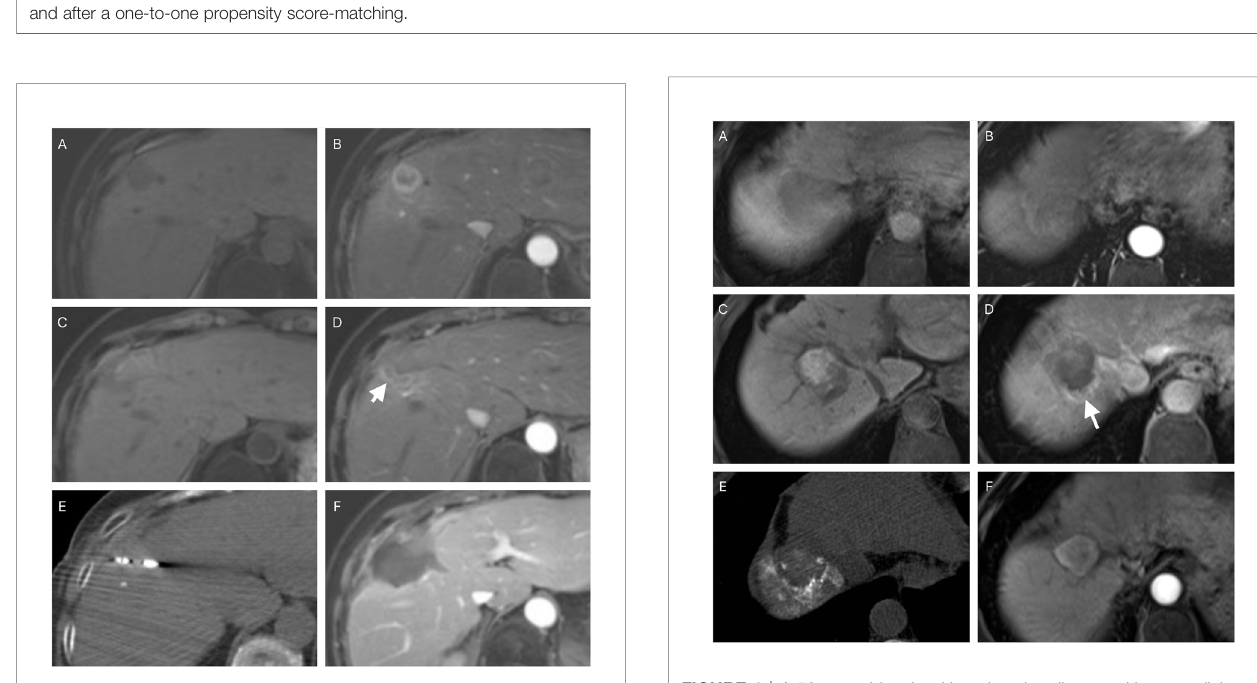
FIGURE 3 | A 62-year-old female with a histopathological proved hepatocellular carcinoma. The pre-ablation magnetic resonance imaging showed the lesion was in the right lobe of the liver (A) and a rim enhancement in arterial phase (B) . The follow-up magnetic resonance imaging was performed four weeks after the ablation and showed residual tumor foci at the edge of the ablative zone (C, D) (white arrow). A repeated ablation was performed (E) . Follow-up magnetic resonance imaging was performed four weeks after the ablation and showed a complete response (F) .